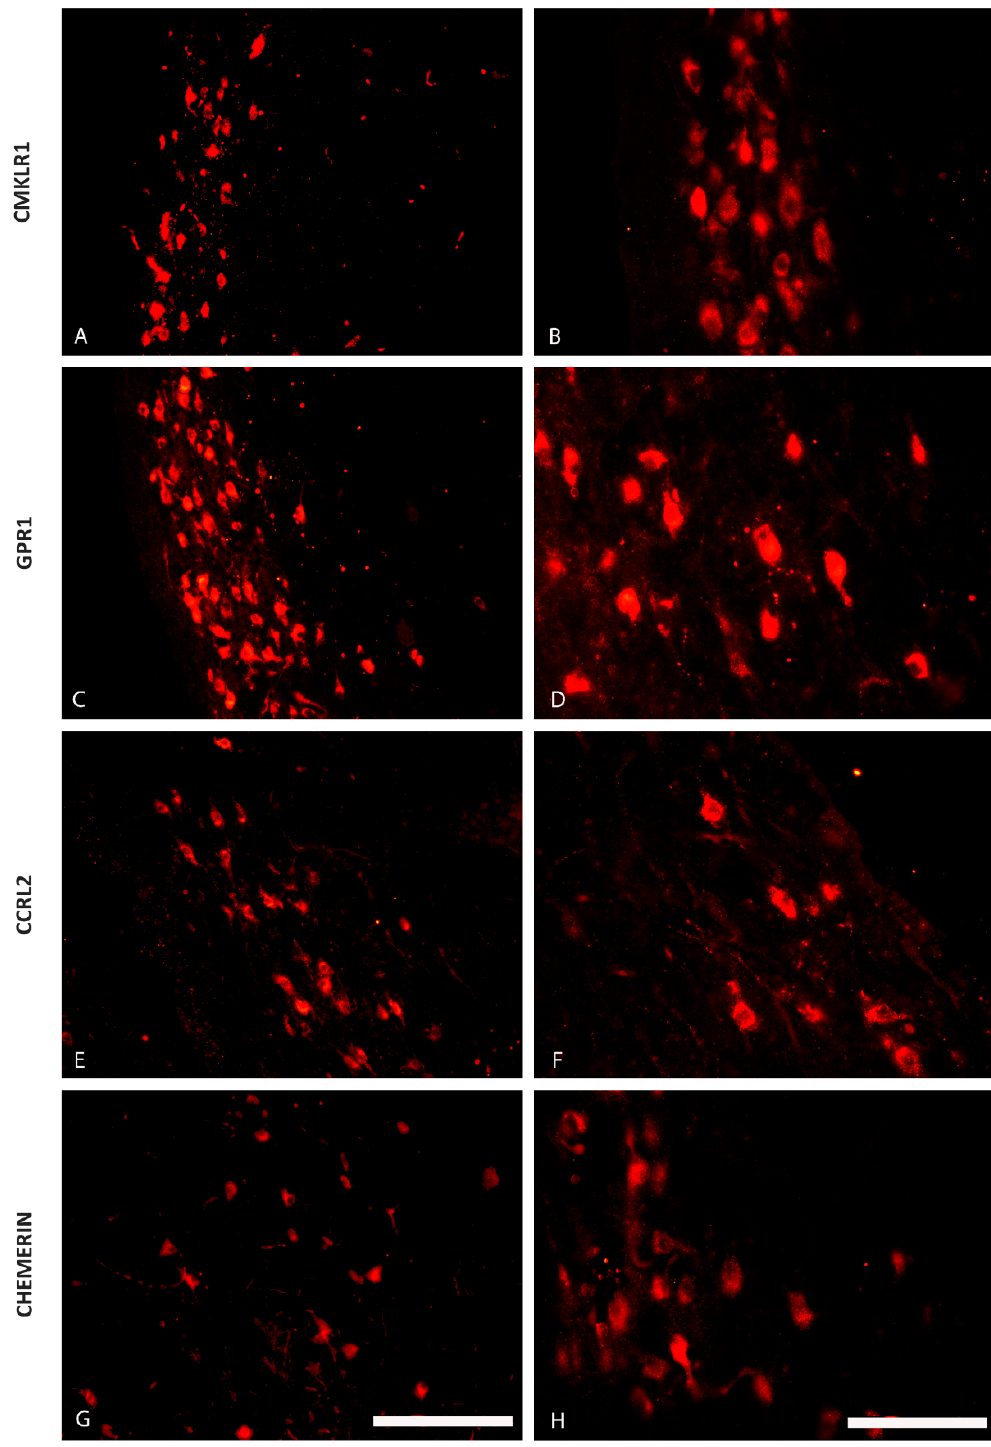
Figure 1. The distribution of the chemerin system in the porcine mediobasal hypothalamus (MBH) during the oestrous cycle. Immunoreactivity of chemokine-like receptor 1 (CMKLR1; A and B ), G protein-coupled receptor 1 (GPR1; C and D ), C-C motif chemokine receptor-like 2 (CCRL2; E and F ) and chemerin ( G and H ) during the oestrous cycle (days 10 to 12) in the hypothalamus of the pig at the level of the paraventricular nucleus. Scale bar: 200 µ m, applies to A, C, E, G; scale bar: 100 µ m, applies to B, D, F, H.